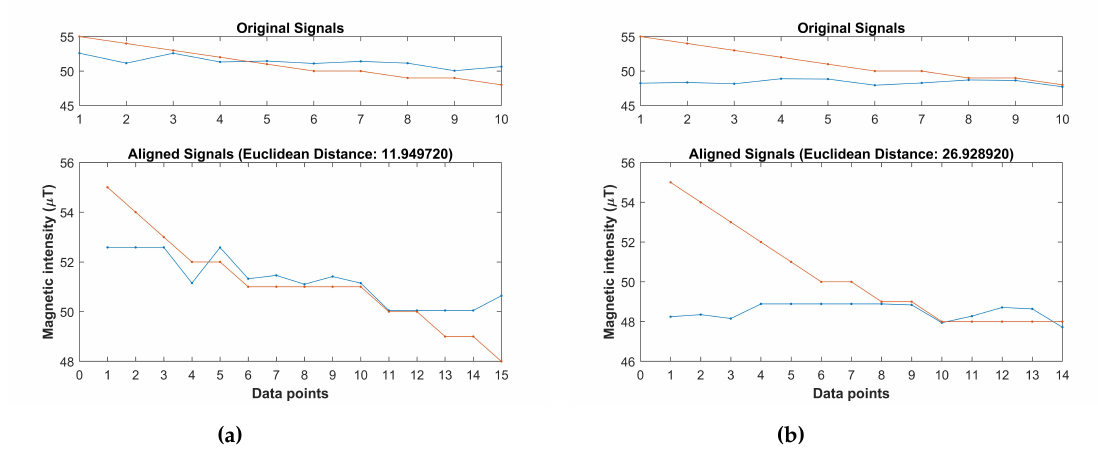
Figure 5. The distance of two samples of the same location during the different time. ( a ) Euclidean distance for sample 1; ( b ) Euclidean distance for sample